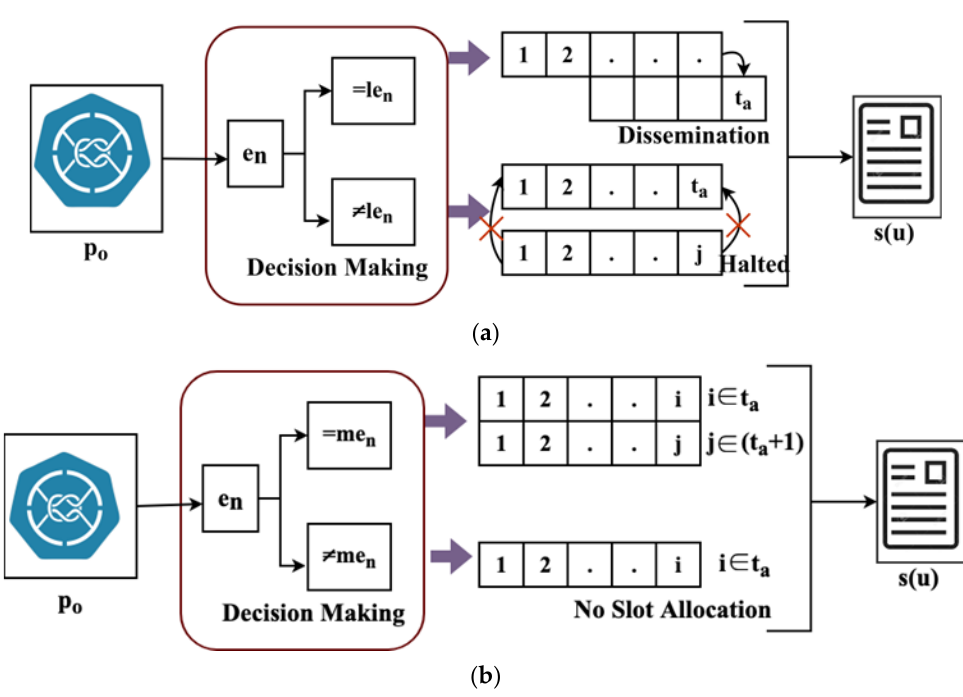
Figure 4. Decision-making based on ( a ) 𝑙𝑒 𝑛 and (b) 𝑚𝑒 𝑛 .